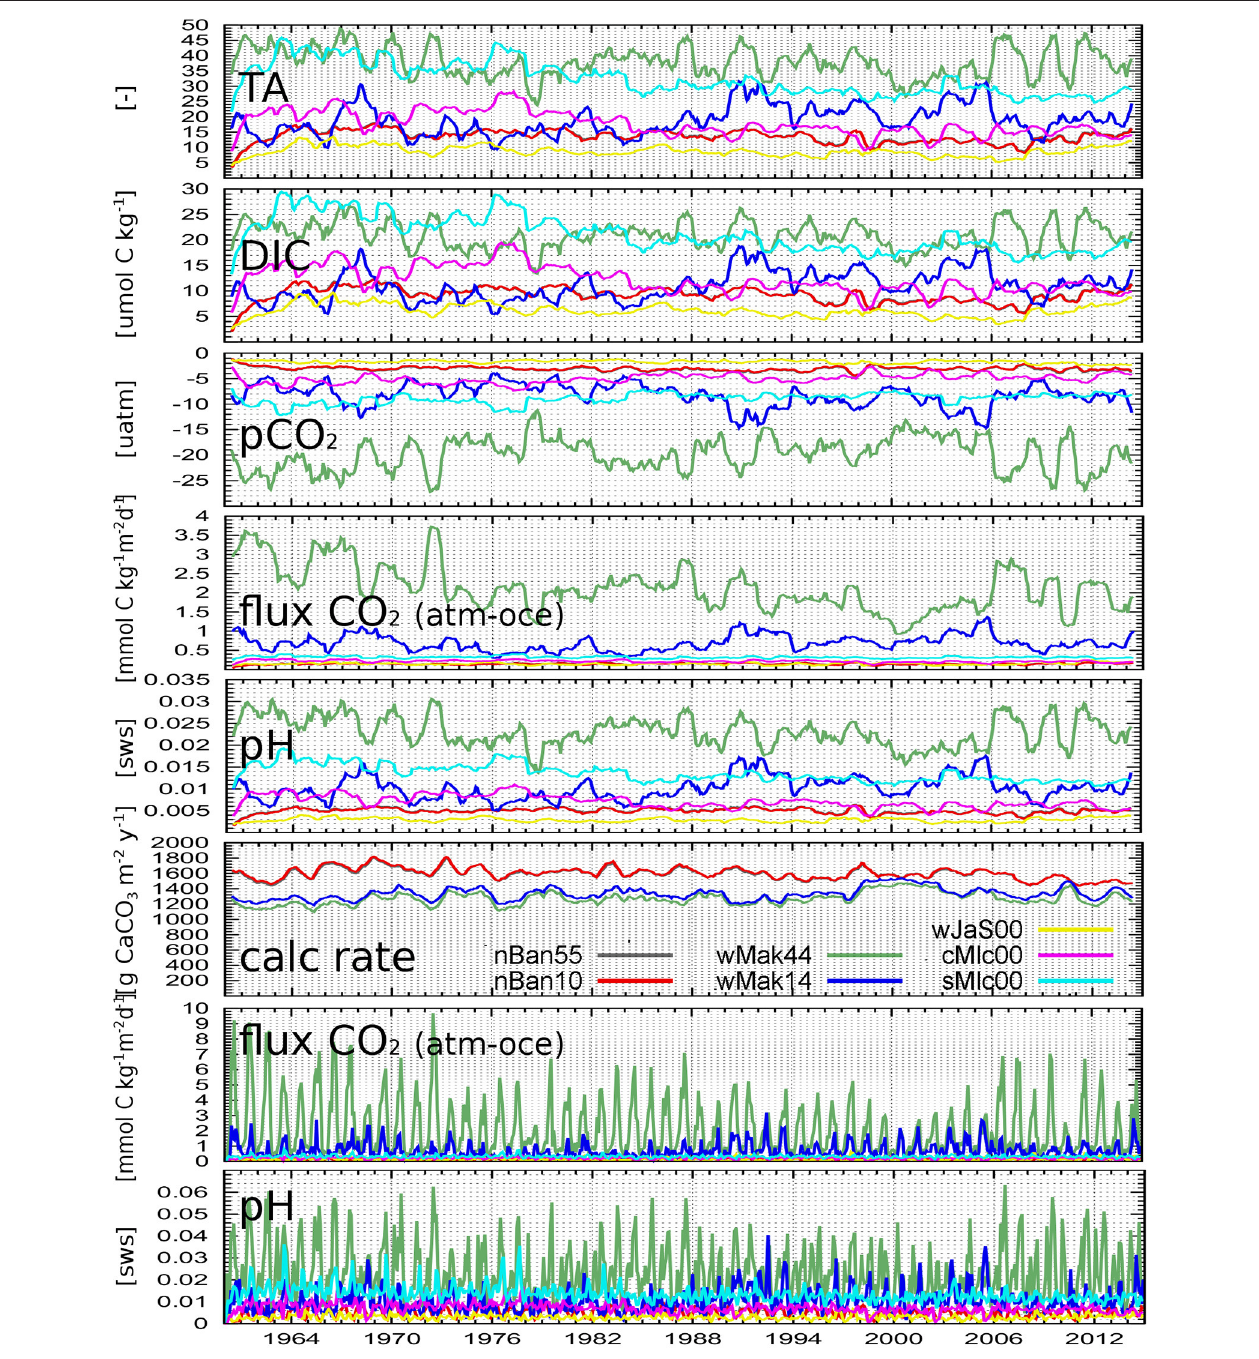
FIGURE 9 | Differences of simulated parameters without-with reef calcification as yearly running means for certain grid points (see Figure 1 ). Colors are mapped to locations in the calc rate graph: nBan: north of Banten Bay, wMak: west of City of Makassar, wJaS: western Java Sea, cMlc/sMlc: central/southern Malacca Strait, numbers in location names mean % of reef coverage. pH is in seawater scale; “calc rate” is aragonite calcification rate (only simulation with corals). CO 2 flux and pH values are shown twice: the lower two panels are monthly values to visualize the seasonal variability. also quite differently. As expected, the changes in the wMak44 14%, green and blue curves in Figure 9 ), which are not direct water are larger for all parameters, e.g., with higher pH decrease neighbors, show slightly different but comparable calcification of around 0.025 at wMak44 vs. 0.01 at wMak14, higher pCO rates per m 2 , but their unequal calcified masses, due to different coral occurrence, influence the water properties in their grid cells